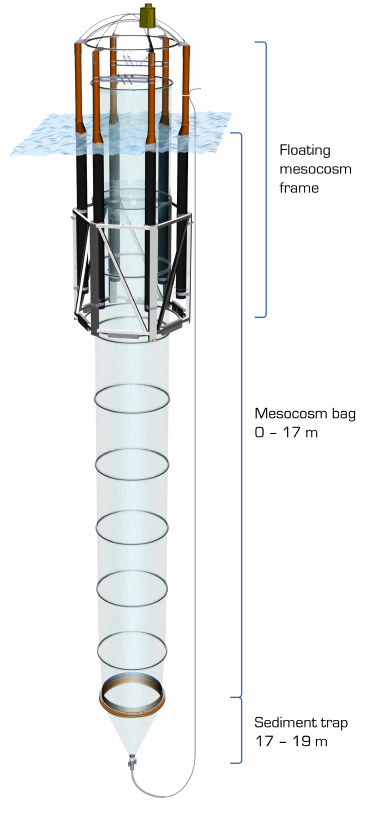
Figure 1. Diagram of Kiel Off-Shore Mesocosm for future Ocean Simulations showing floating frame, mesocosm bag and attached sediment trap. Source: GEOMAR.